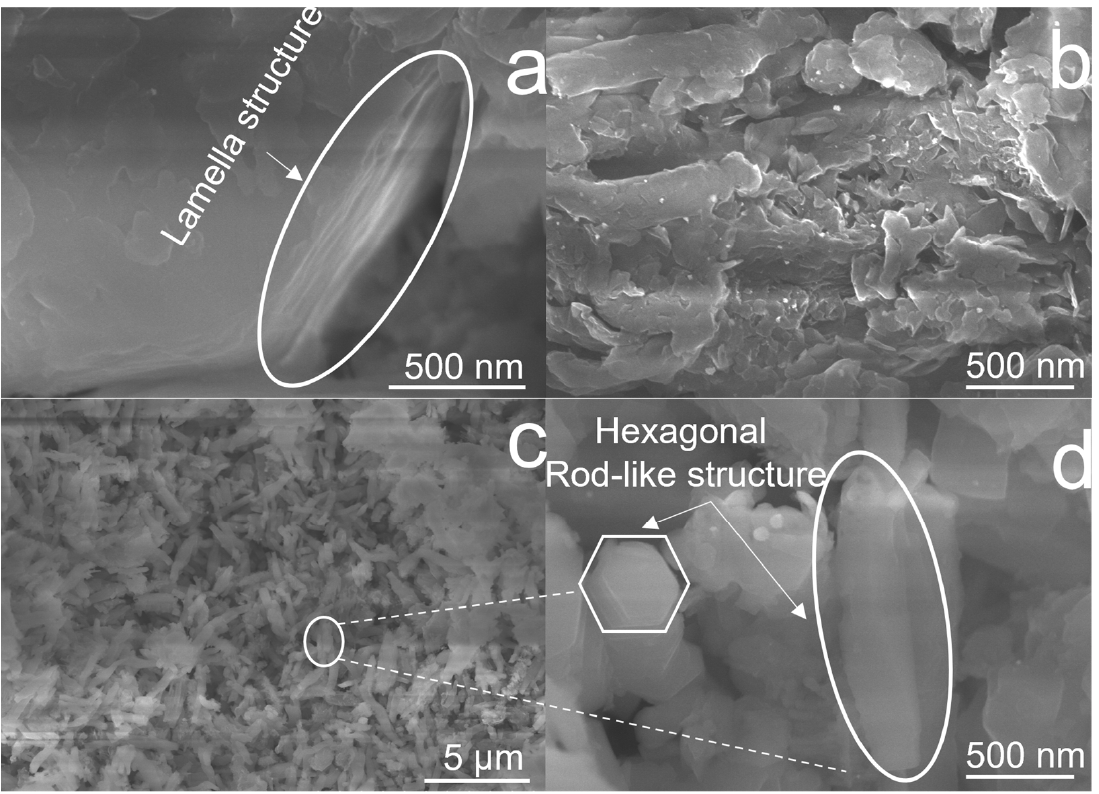
Figure 3. FE ‐ SEM images of ( a ) CN0 ‐ Pt, ( b ) CN3 ‐ Pt, and ( c , d ) CN9 ‐